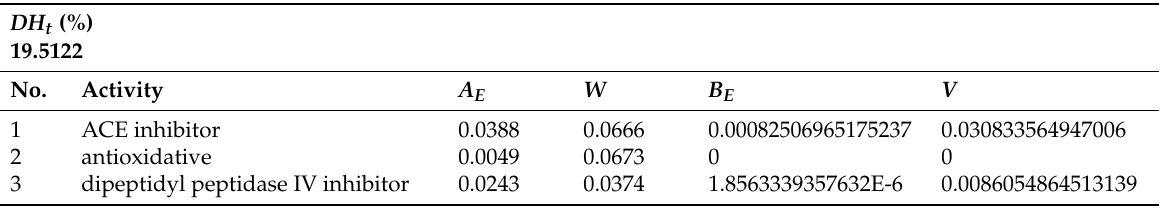
Table A26. A E , DH t , W , B E and V values from RubisCO of Halophila stipulacea . In silico enzymatic cleavage was carried out by chymase.